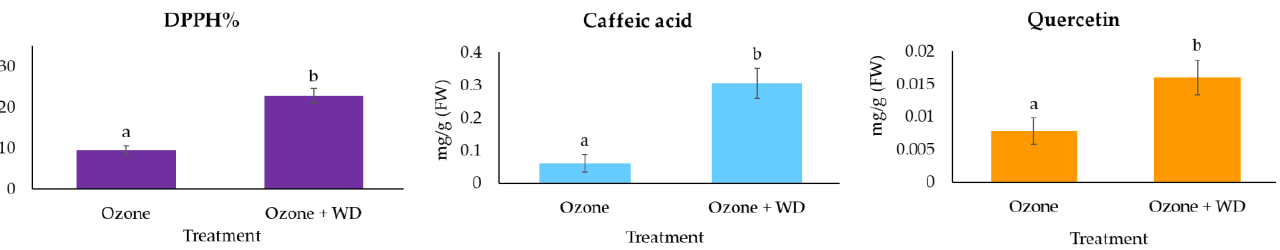
Different letters indicate statistically significant ( p < 0.05) differences between treatments. Abbrevi- ations: absorbance for excited cross-section (ABS/CS 0 ), heat dissipation for excited cross-section (DI 0 /CS 0 ), trapping flux for excited cross-section (TR 0 /CS 0 ), energy transmission for excited cross- section (ET 0 /CS 0 ), number of reaction centers for excited cross-section (RC/CS 0 ), photosynthetic effi- ciency (F V /F M ), performance index (PI ABS ), chlorophyll content (Chlorophyll). 4. Discussion Lettuce is an ozone-sensitive horticultural plant [34] and O 3 fumigations caused a decrease in photosynthesis, chlorophyll content, and biomass of this species, consistently with other studies [35,36]. However, when 0.2% WD was sprayed on the leaves, plants showed an improvement in the photosynthetic system, a higher content of chlorophyll